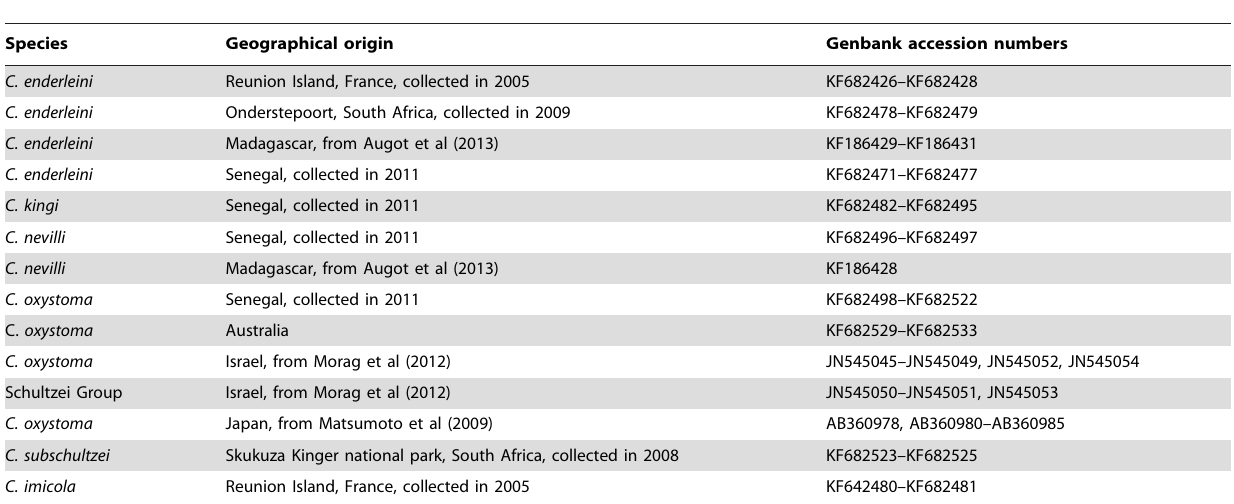
Table 1. Female samples used for the molecular analysis, localization and Genbank accession numbers for the COI